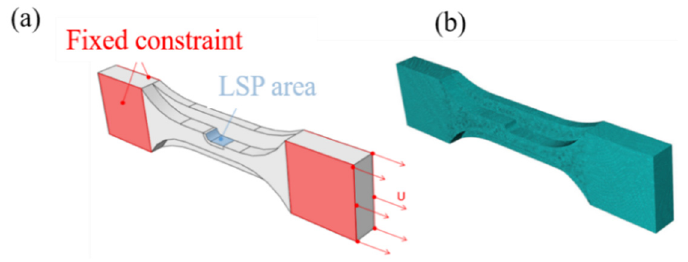
Figure 4. ( a ) Frame beam model of TC6 titanium alloy, ( b ) mesh model.